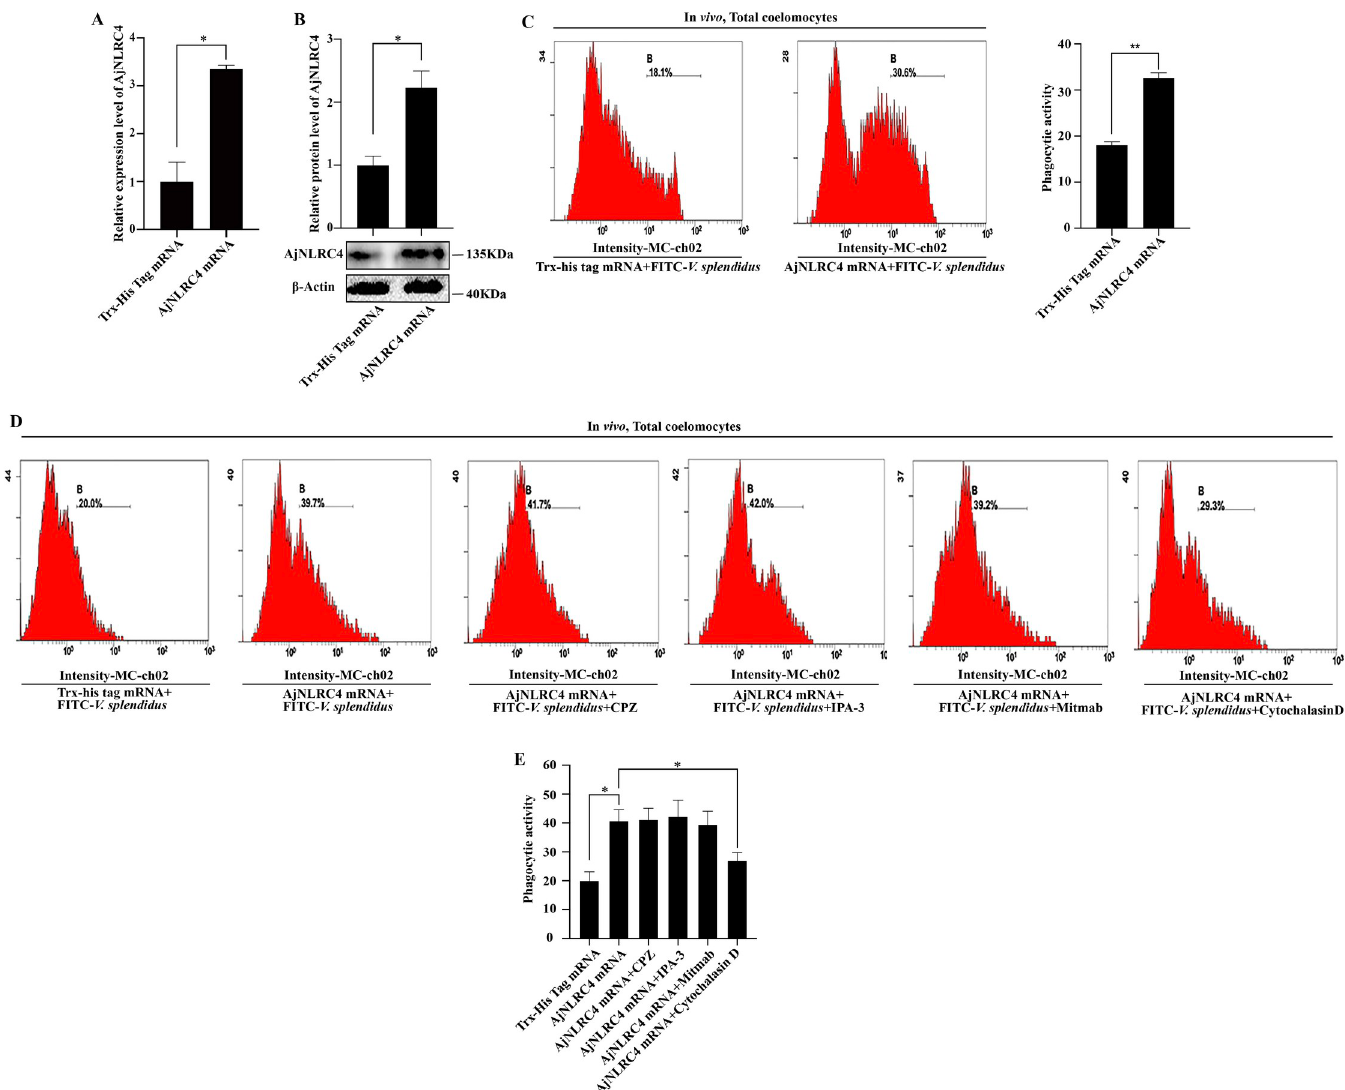
Fig 6. Internalized AjNLRC4 promotes V . splendidus phagocytosis via the actin-mediated endocytic pathway. (A-B) The efficiency of AjNLRC4 overexpression in coelomocytes, as determined using qPCR and western blotting analysis. The graphs are representative of three independent assays, and the proportions were calculated from those three assays, � p < 0.05. (C) Flow cytometry was performed to investigate the phagocytic activity of V . splendidus after the overexpression of AjNLRC4. The graphs are representative of three independent assays, and the proportions were calculated from those three assays, �� p < 0.01. (D-E) After the overexpression of AjNLRC4, the inhibitors were added, and then, flow cytometry was performed to detect the phagocytic activity.